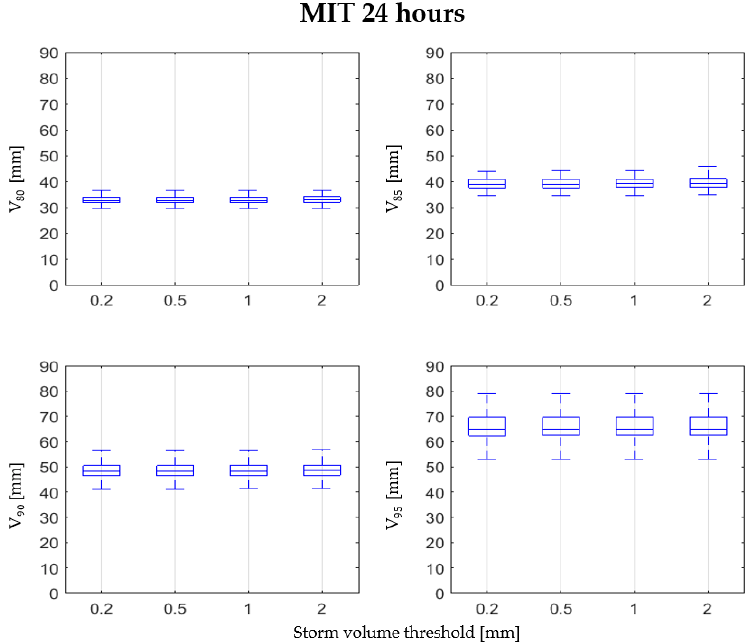
Figure 11. Effect of different storm volume thresholds on values of volumetric percentiles that treat a percentage of the total volume of accumulated rainfall series, for simulated rainfall series and a fixed 24 h MIT value.